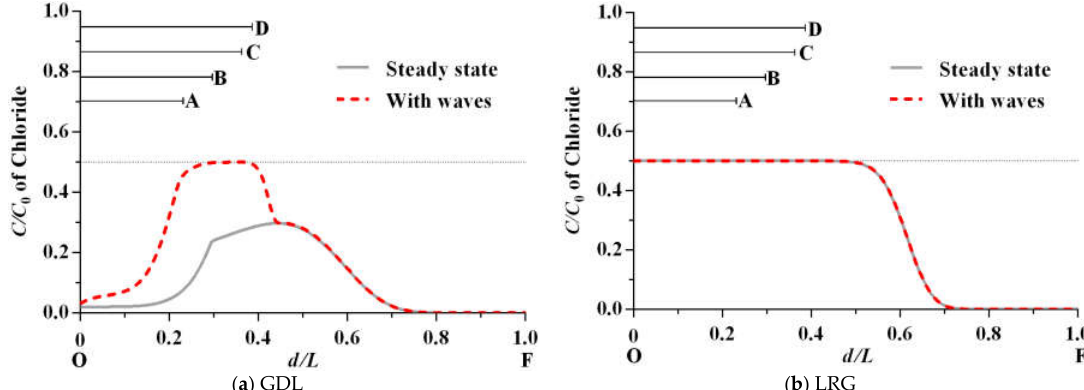
Figure 8. Distributions of chloride concentrations along the lake–groundwater interface (OF) at no-wave conditions in the GDL ( a ) and LRG ( b ) cases and one day after wind waves started. See Figure 1 for the locations of points A, B, C, D, F, and O. Horizontal solid lines represent relative distances of points A, B, C, and D from point O. C 0 : the input chloride concentration from the fishpond/paddyfield. The gray horizontal dashed line at C / C 0 = 0.5 represents the relative chloride concentration in lake water.